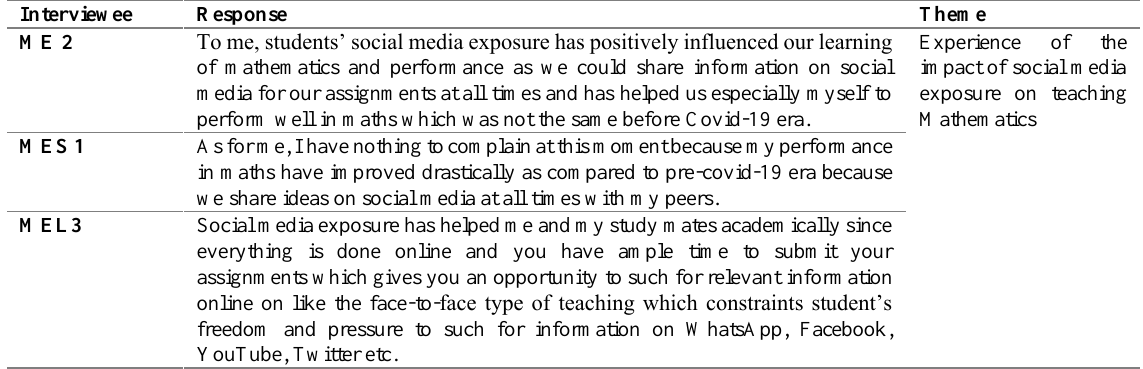
Table 7: Question 7 - What is your experience of the impact of social media exposure on teaching Mathematics?